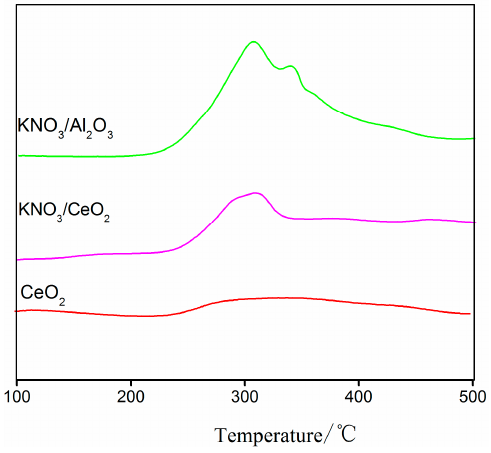
Figure 1. CO 2 ‐ temperature ‐ programmed desorption (TPD) analysis for the catalysts.